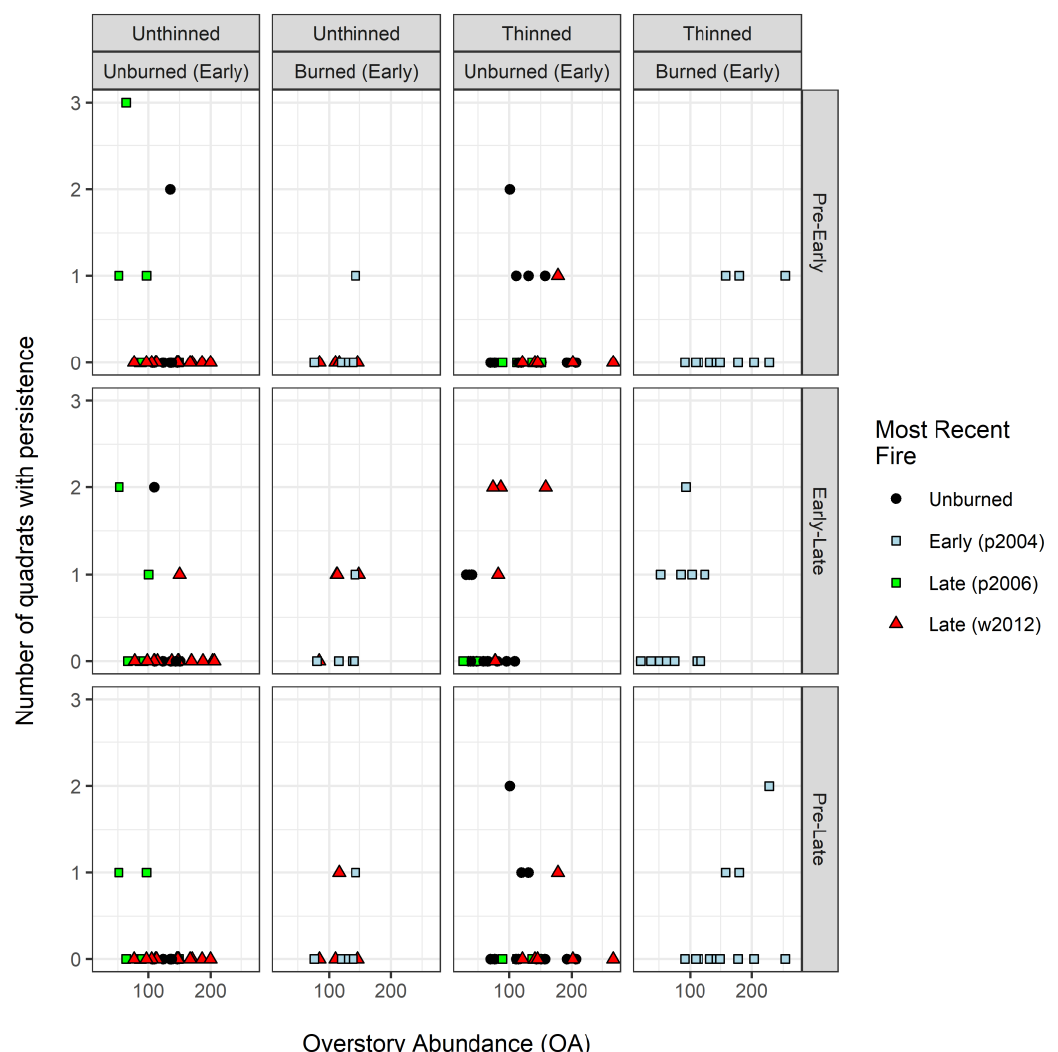
Figure 7. Persistence of seedlings ( < 1 m tall) expressed as the number of quadrats per plot in which seedlings were present at both the start and end of the sampling interval. Rows distinguish Pre–Early, Early–Late, and Pre–Late intervals. For each interval, plot values of OA represent the start of the interval. See Figure 3 for other details; modeled results are not shown (lack of convergence due to low sample sizes).